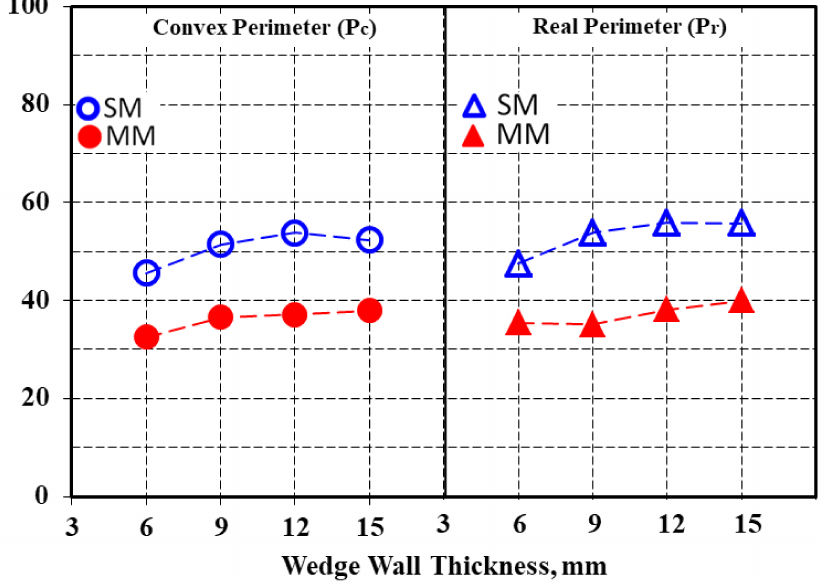
Figure 5. Influence of the mold media and wall thickness on the values of the convex and real perimeters of the graphite